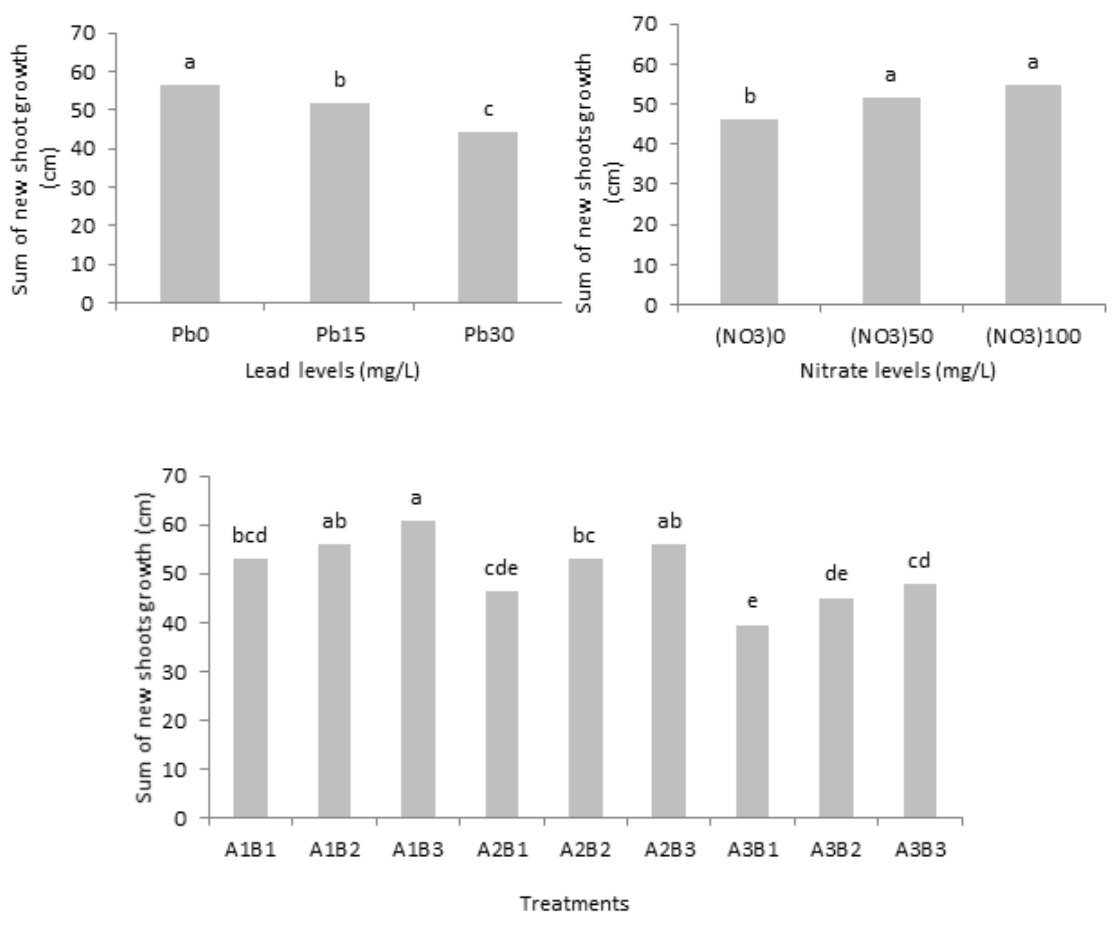
Figure 4: Sum of new shoots growth of Judas tree plants under interaction of lead and nitrate applications. Treatments indicate lead levels (A: 0, 15, 30 mg L -1 ) and nitrate levels (B: 0, 50, 100 mg L -1 ). Data are average of four replications ±SD. Comparison of means was done at 5% level of LSD